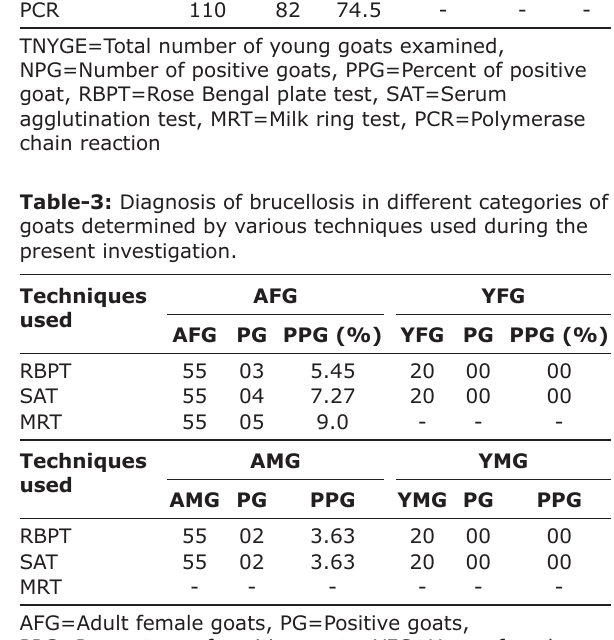
test, MRT=Milk ring